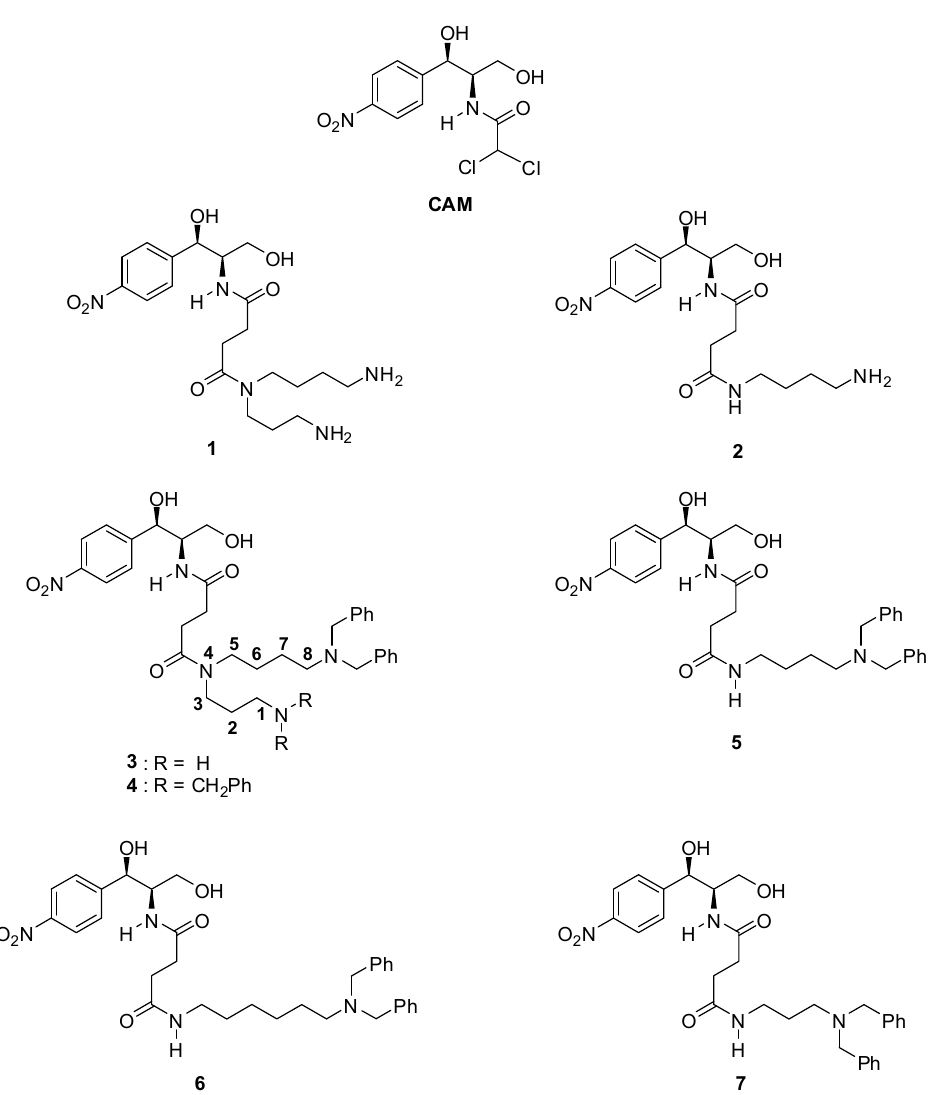
Figure 1. Structures of compounds encountered in the present work.